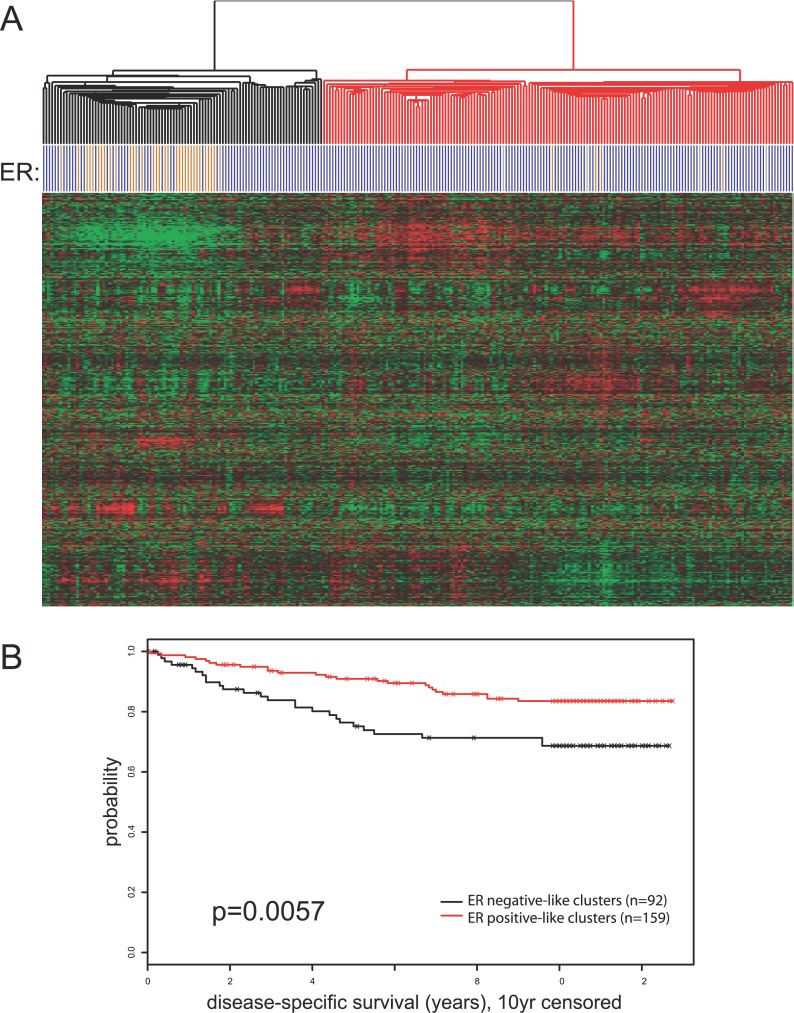
ER Binding Sites Are Adjacent to Genes Associated with ER-Status and Disease Outcome in Breast Cancer Patients(A) Expression profiles of genes adjacent to the 1,234 ER binding sites (<100 kb) cluster 260 breast cancer patients into ER+ and ER− groups. ER status is indicated by blue (ER+) and orange (ER−) bars beneath each patient sample.(B) Kaplan-Meier analysis of disease outcome indicates significantly longer survival for patients with the ER+ profile (red) and compared to those in the ER− cluster (black).